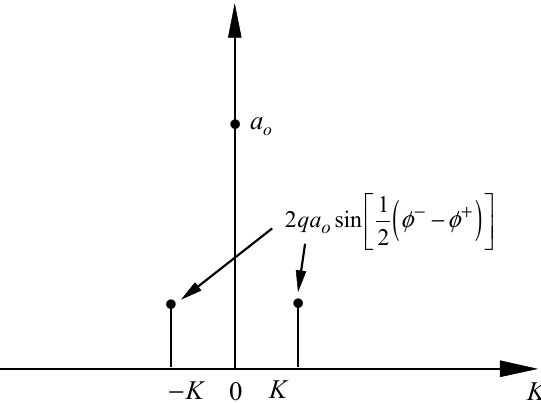
Figure 2. Fourier wavenumber spectrum of the complex envelope of the nonlinear Schrödinger equation computed to leading order in the nome q for a small amplitude modulation (Equation (37)). Here we have the carrier wave of amplitude a o , together with two small side bands.